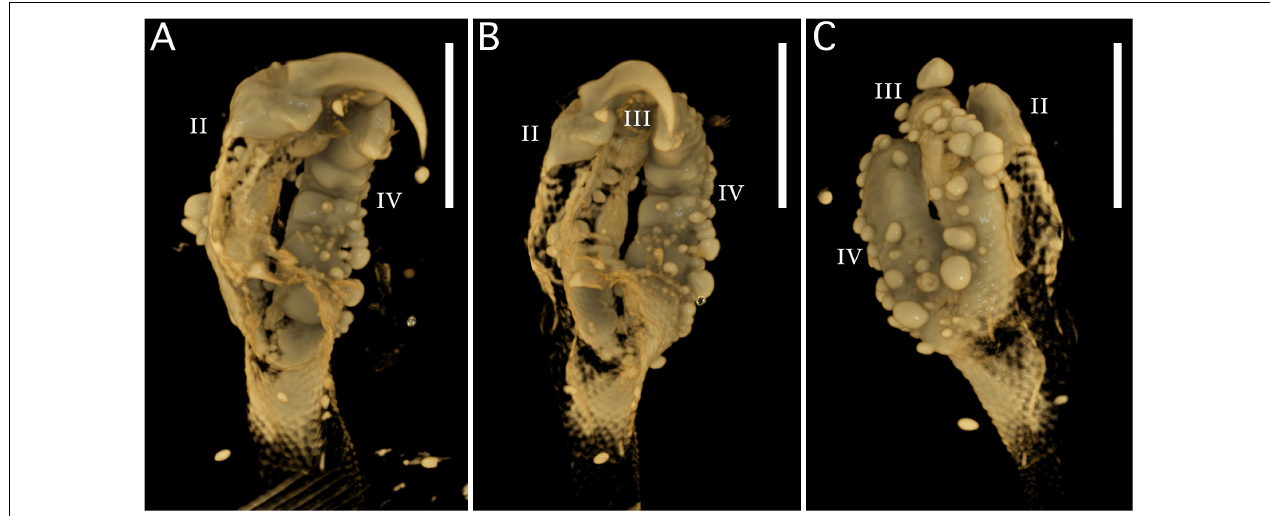
FIGURE 3 | The external surface of the partial left pes of YLSNHM01001 in (A) medial, (B) ventral, and (C) dorsal views. Note digit I (hallux) is missing from the specimen but is assumed to be a feature based on known enantiornithine pedal morphology. Scale bars = 5 mm, (A–C) Photographs of specimen YLSNHM01001 credited to Lida Xing, used with permission from Jingmai